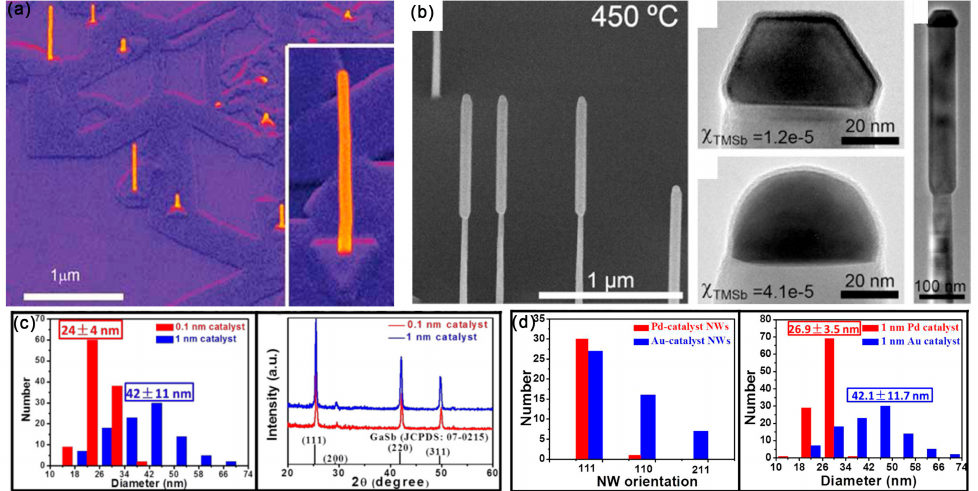
Figure 2. ( a ) The general morphology of InAs NWs on GaAs (111) B substrates. Reproduced with permission [24]. Copyright 2009, Wiley-VCH Verlag GmbH & Co. KGaA, Weinheim. ( b ) SEM and TEM image of GaAs/GaSb nanowires showing the characteristic larger diameter of the GaSb segment. Reproduced with permission [25]. Copyright 2008, Elsevier B.V. ( c ) CMOS-compatible catalyst of Pd was used for the GaSb NW growth. Reproduced with permission [29]. Copyright 2017, American Chemical Society. ( d ) Diameter distribution and crystal structure of the as-prepared GaSb NWs. SEM images of GaSb NWs prepared by using the 0.1 and 1 nm thick Au films as the catalyst. Reproduced with permission [30]. Copyright 2015, American Chemical